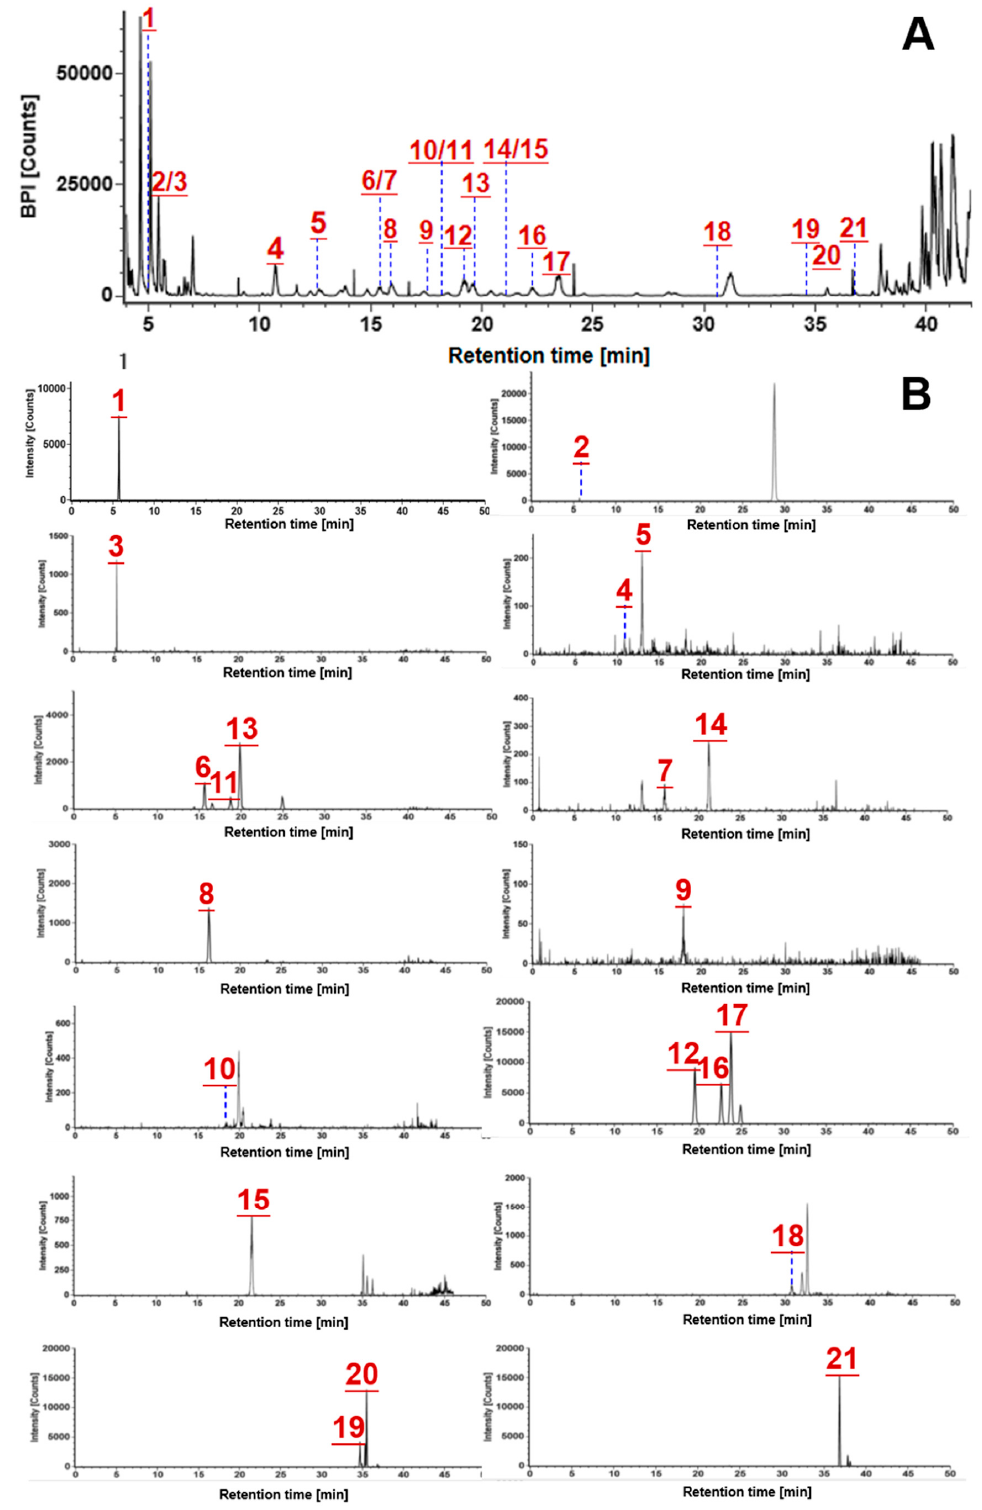
Figure 5. Characterization of the prototype components in rat plasma: ( A )—the base peak chro- matogram of PNF-administrated rat plasma; ( B )—the extracted ion chromatogram (EIC) for those identified with the aid of reference compounds ( 1 , noto-R1; 2 , Re; 3 , Rg1; 4 , noto-R4; 5 , noto-Fa; 6 , noto-FP2; 7 , noto-Fh1; 8 , Rb1; 9 , Ro; 10 , m-Rb1; 11 , noto-Fc; 12 , Rc; 13 , Ra1; 14 , noto-S; 15 , F1; 16 , Rb2; 17 , Rb3; 18 , m-Rd; 19 , noto-Fe; 20 , Rd 2 ; 21 ,